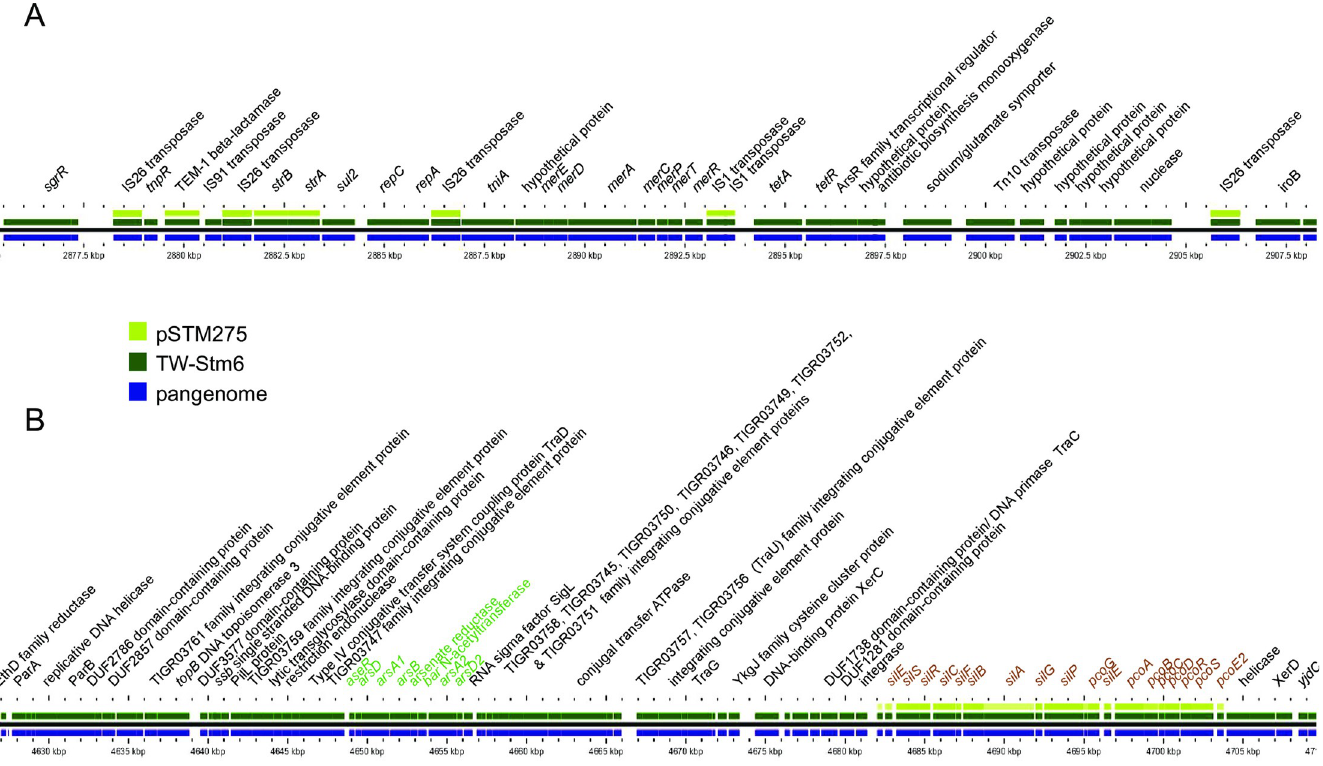
Fig 13. Comparison of the SGI-4 and MREL content of plasmids pSTM275 and TW-Stm6. GView pangenome analysis using TW-Stm as the reference genome. Data were analyzed as in Figs 5–7.